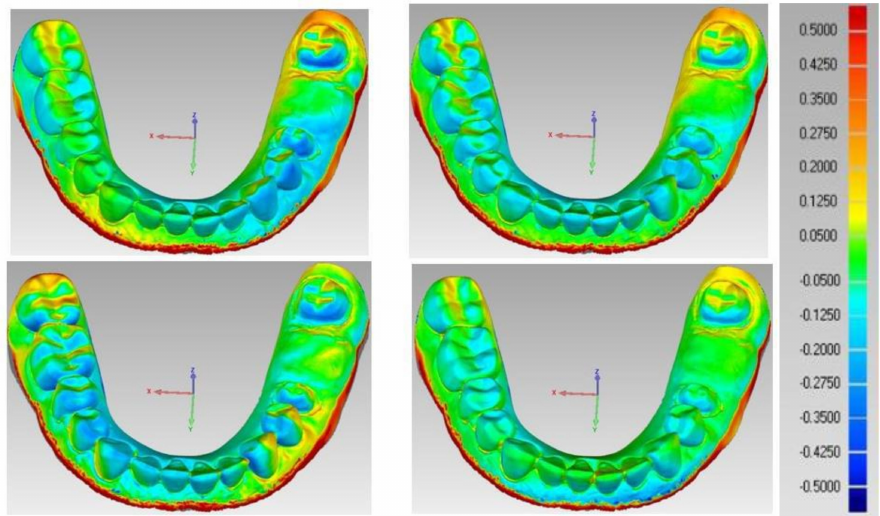
Figure 14. Color map of printed